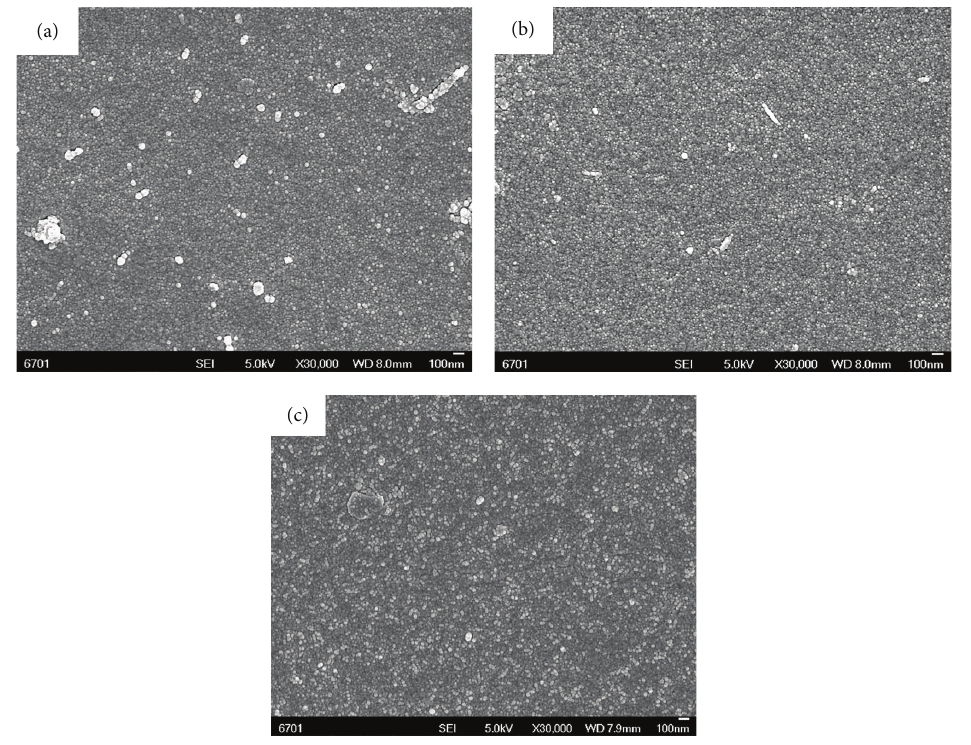
Figure 5: SEM images of M-PAANa prepared at different electric potential: (a) − 0.08, (b) − 0.12, and (c) − 0.2